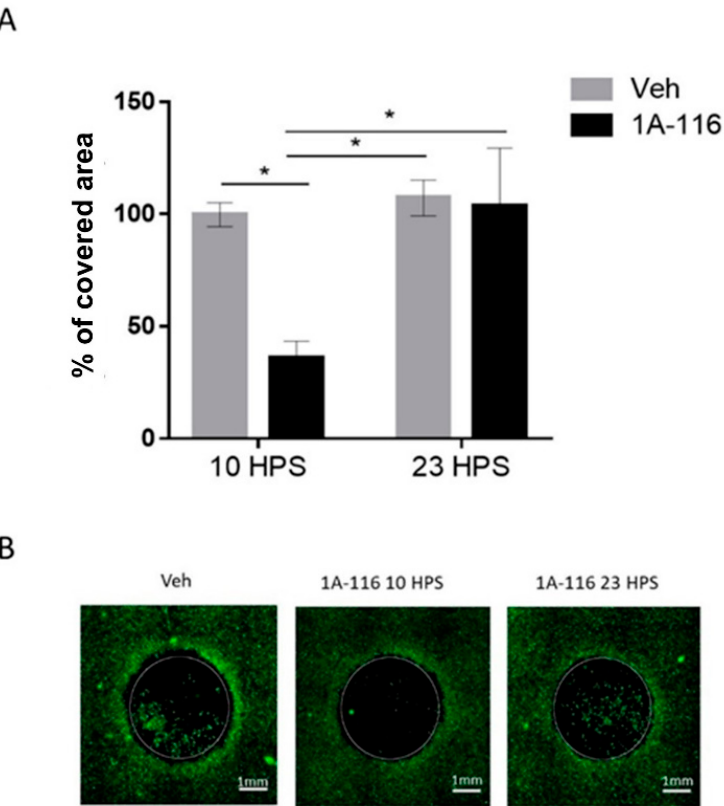
Figure 4. Cell migration inhibition due to 1A-116 at 10 HPS. Cell migration into a cell-free area was measured in cultures treated with 1A-116 (10 µ M) or vehicle at either 10 HPS or 23 HPS. At 16h after treatment, live cells were stained with Calcein-AM. The area covered by cells in the previously cell-free area was measured with ImageJ software. The total covered area by the cells was normalized to the covered area of the vehicle (control), after the area outside the cell-free area and technical controls (t0) were subtracted out from the data. ( A ) The covered area for 10 μ M treated cells was significantly reduced at 10 HPS than at 23 HPS (Two-way ANOVA, for factor HPS, * p < 0.05, for factor concentration, * p < 0.05. Sidak’s multiple comparisons test: 1A-116 10 HPS vs. 23 HPS: * p < 0.05; 10 HPS Veh vs. 1A-116: * p < 0.05, 10 HPS 1A-116 vs. 23 HPS Veh: p < 0.05, N = 4). Column plots represent the mean ± SEM. ( B ) Representative images of the migration area at 16 h after treatment. The white scale bar represents 1 mm, and the white circles represent the originally cell-free area where cell migration was quantified.